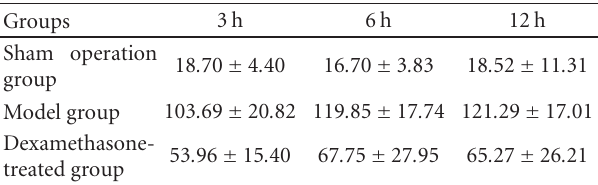
Table 3: Comparison of PLA 2 in serum ( X ± S ).